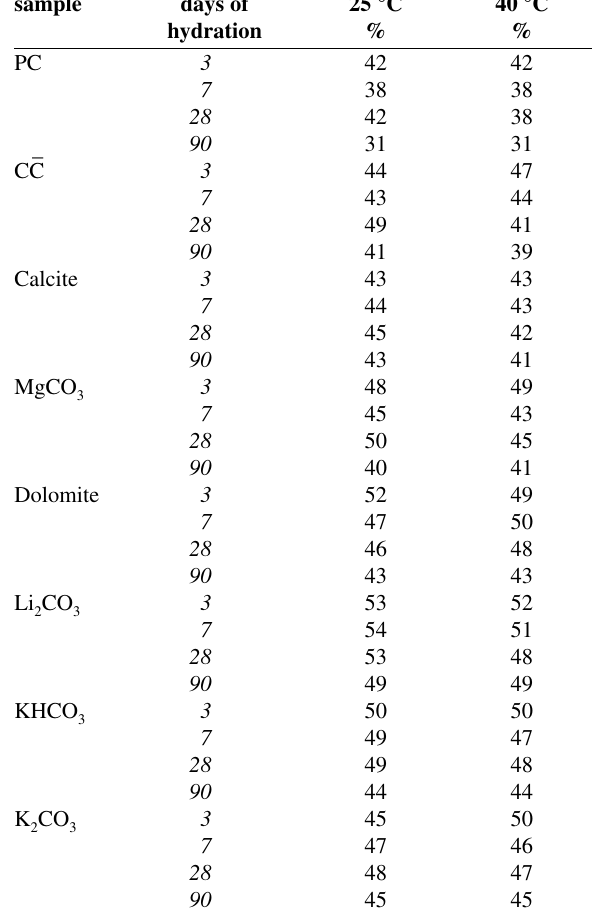
Table 2. The crystallinity of samples in dependence on the level of hydration and the temperature. sample